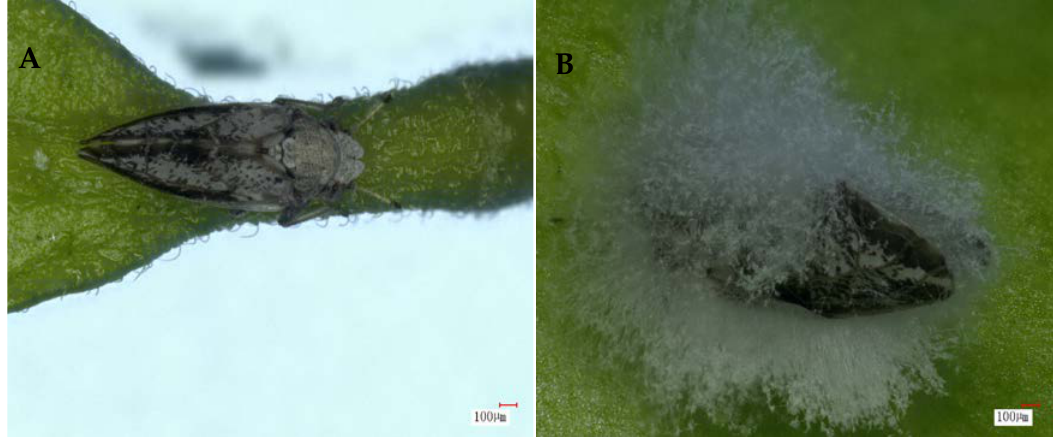
Figure 5. ( A ) Healthy Diaphorina citri adult ( B ) D. citri adult colonized with Cordyceps javanica.